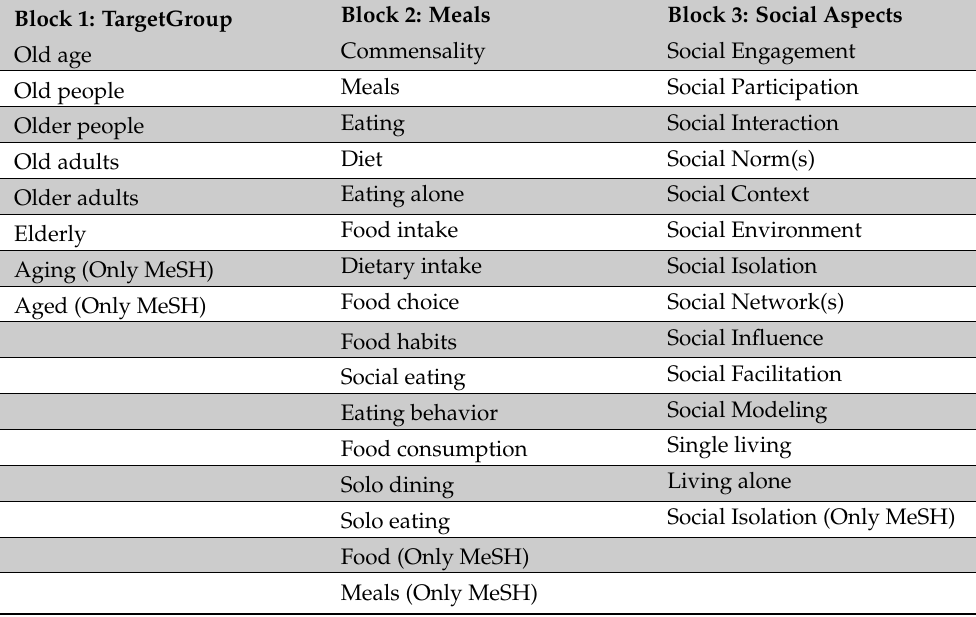
electronic search strategy; Table S3: Articles in the third category: peripheral; Table S4: Geographical spread of included